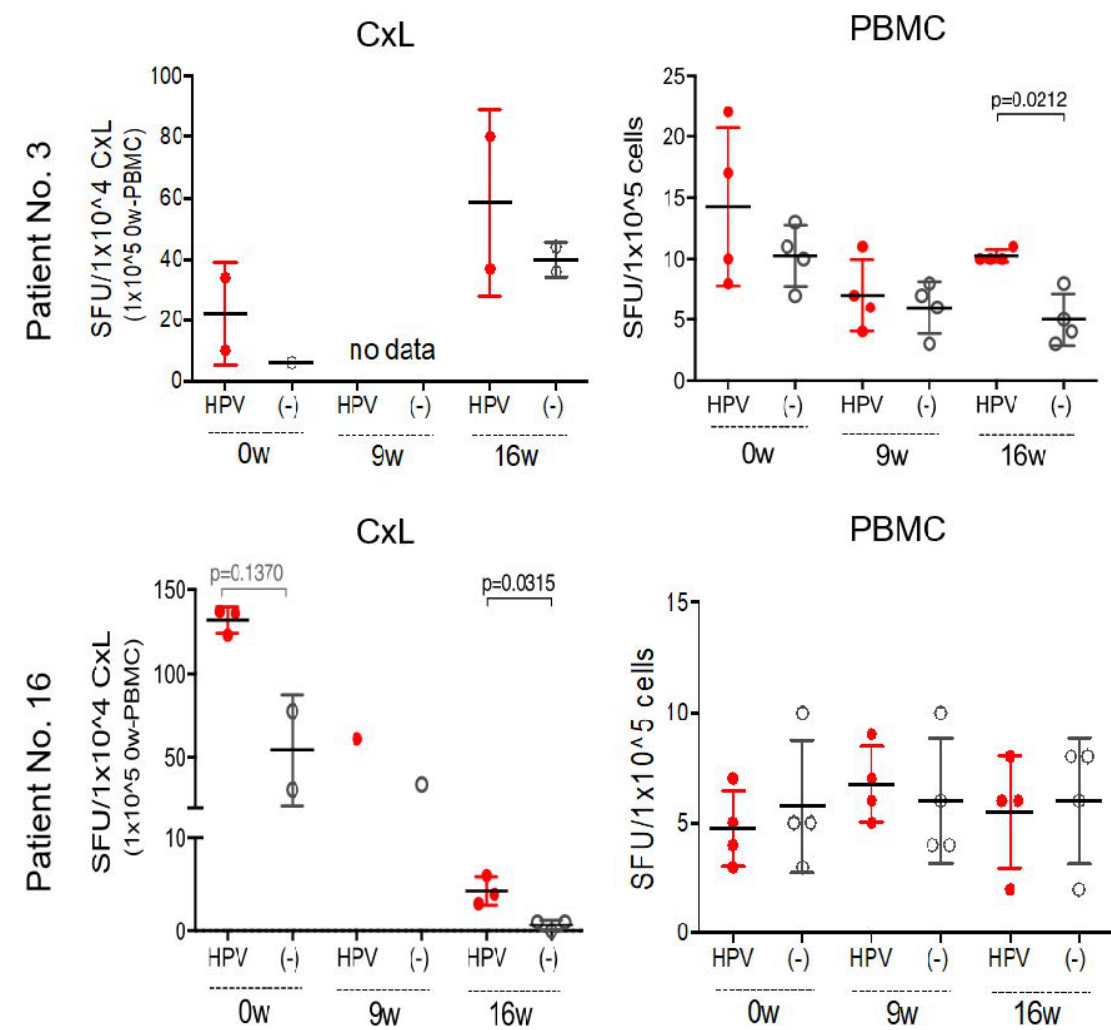
Figure 4. Increase in the number of IFN γ -producing cells in the patients with CR. The number of spots of CxL and PBMC at pre-immune (0week), 9 week, and 16 week was shown for patients 3 and 16 of CR cases that regressed to normal within only 4 months. In both cases, at week 16, E7 stimulation (HPV+; red dot) was significantly elevated compared to no E7 stimulation although the number of spots without stimulation (black dot) varied from specimen to specimen.